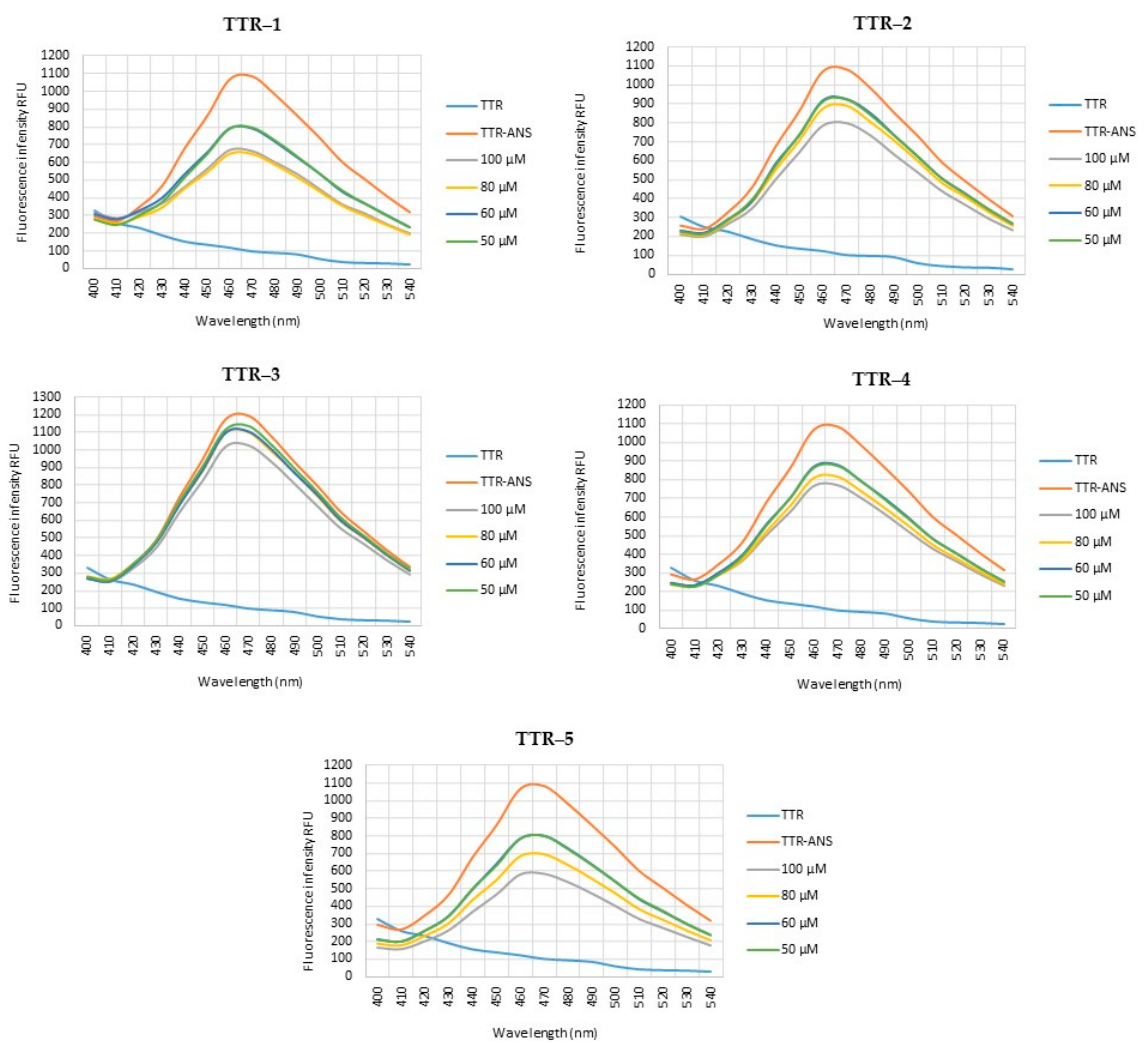
Figure 5. Displacement of ANS by glycosylated derivatives 1 – 5 . TTR was incubated in the absence or presence of ANS (ratio 1:2) for 15 min. TTR-ANS complex was added after different concentrations (100 µM, 80 µM, 60 µM and 50 µM) of compounds 1 ‒ 5 . The fluorescence emission spectra (400–540 nm) were recorded by exiting at 280 nm.